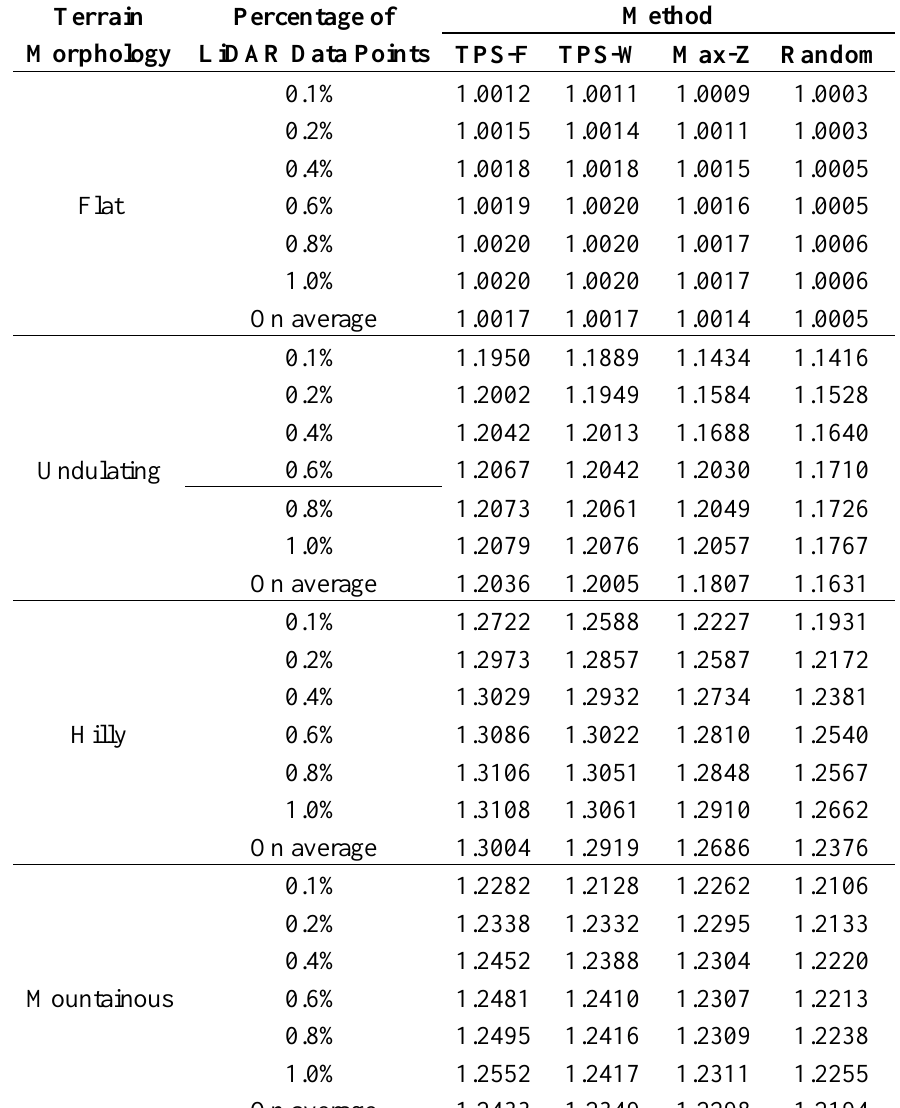
Table 3. Terrain roughness of TPS-F, TPS-W, max-Z and the random method in the four study sites with different percentages of LiDAR data points.